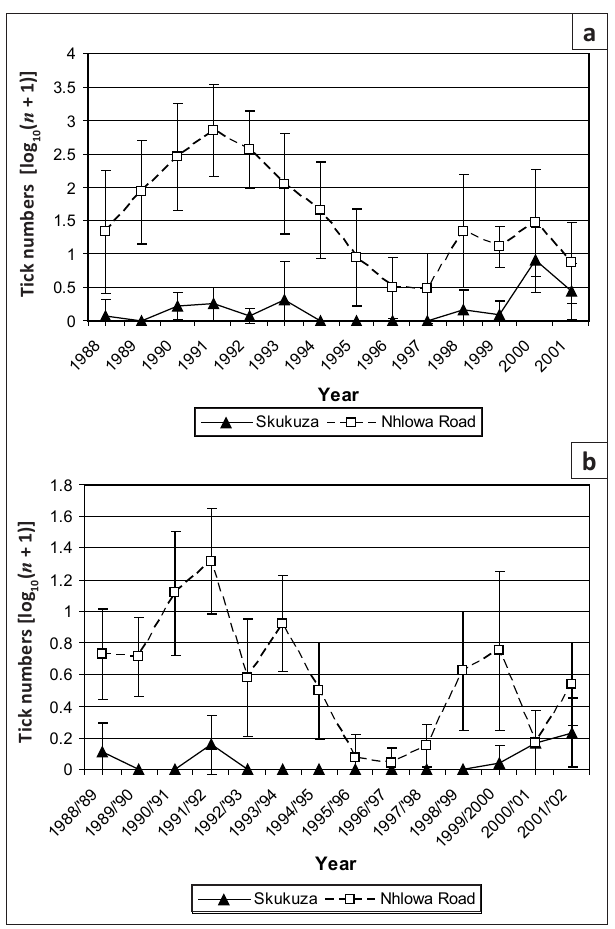
FIGURE 2: Mean (± 95% confidence interval) monthly collections of Rhipicephalus appendiculatus a) larvae and b) nymphs during the active periods by year at Nhlowa Road and